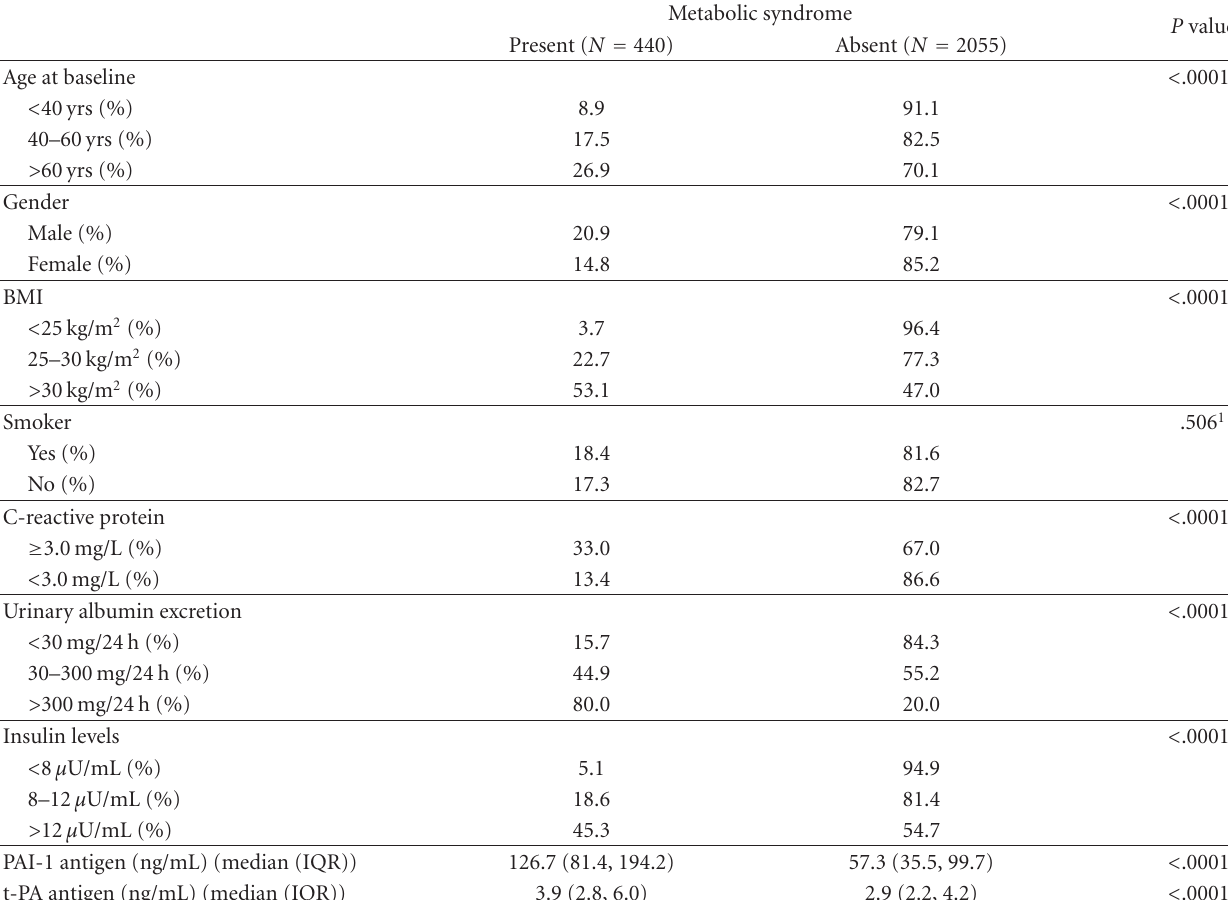
Table 1: Characteristics of the study population by presence or absence of the metabolic